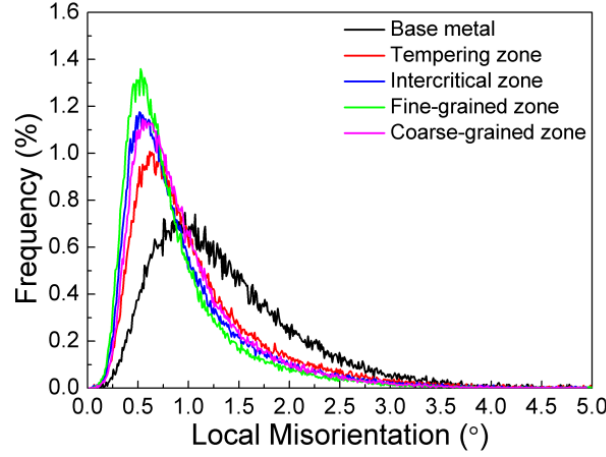
Figure 6. Quantitative analysis of local misorientation of various peak temperatures.